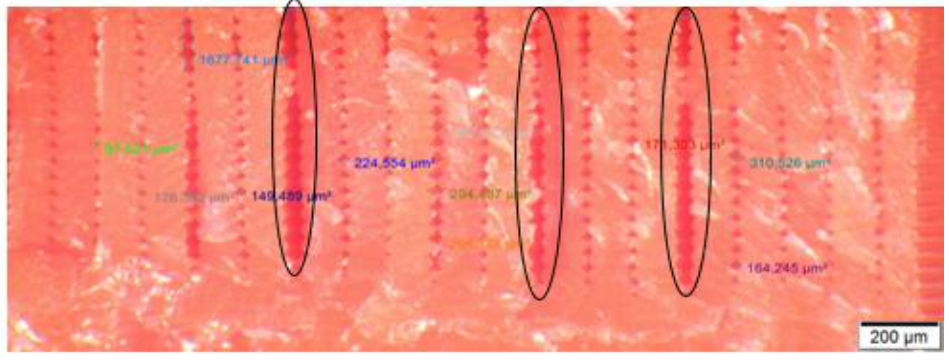
Figure 10. The cross-sectional image of a broken FDM 3D-printed specimen in a 5-bar condition.